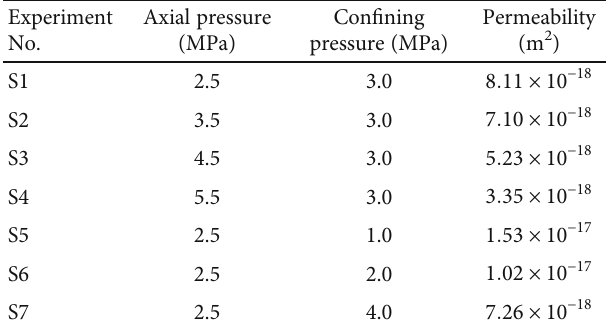
Table 5: Permeability range analysis. Table 4: Results of the orthogonal experiments on permeability.